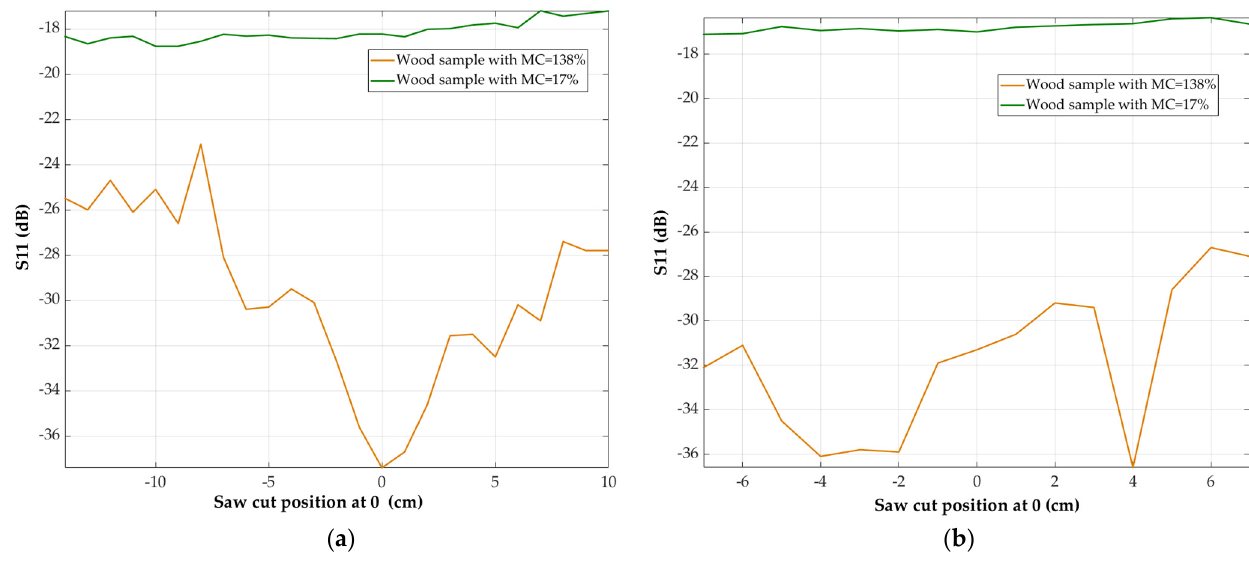
Figure 13. S 11 measurements for wet and dry wood samples above the saw cut: ( a ) E-field parallel to the wood grain and perpendicular to the cut (reverse side); ( b ) E-field perpendicular to the wood grain and parallel to the cut (reverse side).